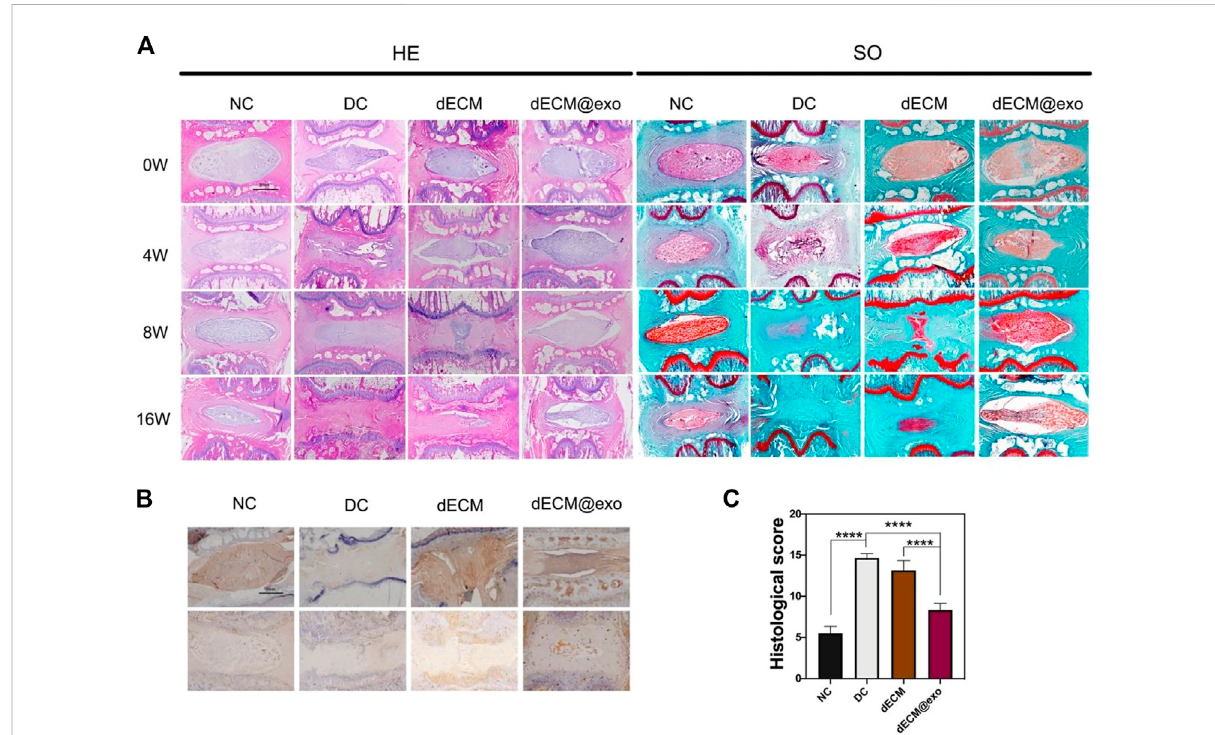
FIGURE 6 Images of each group were obtained by H&E and saffron O staining method at different times (A) . Scale bar = 1 mm. Immunohistochemical imagesofaggrecanandcollagenIIwereexamined (B) .Quantitativeanalysisofhistologicalgradeineachgroupat16 weeks (C) .*means p < 0.05.NC: normal disc group. DC: degenerated disc group. dECM: only the hydrogel was injected. dECM@exo: hydrogel containing exosomes were injected. Reproduced with permission from (Xing et al.,